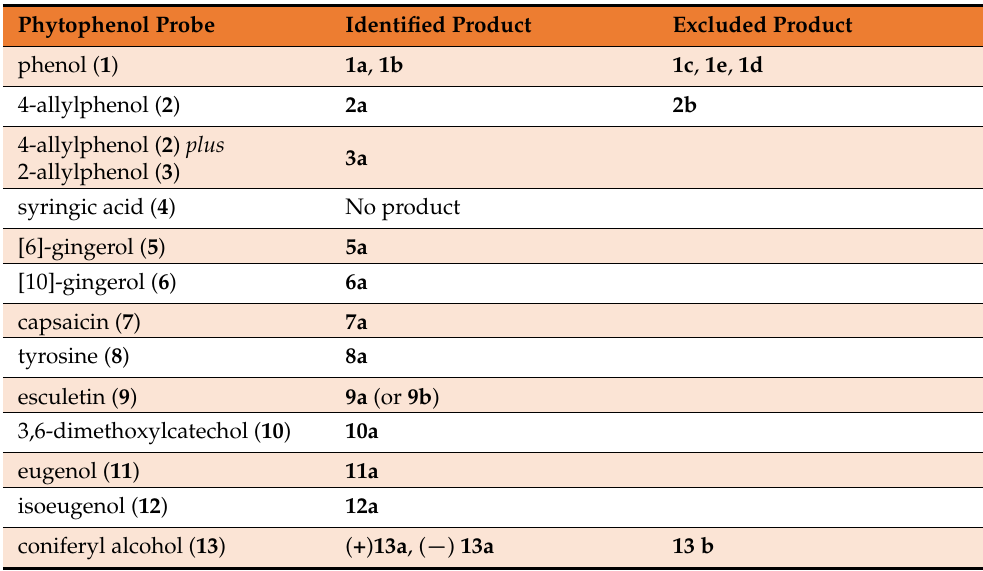
Table 1. Thirteen phytophenol probes, 15 identified dimeric products, and five excluded dimeric products. Phytophenol